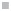
Effects of levosimendan on intracellular cAMP and cGMP in human PAs and PVs.A): cAMP:
■ PA: control (n = 5); ■ PA: 1 μM levosimendan (n = 4); ■ PA: 100 μM levosimendan (n = 7); ■ PV: control (n = 6); ■ PV: 1 μM levosimendan (n = 4); ■ PV: 100 μM levosimendan (n = 8). B): cGMP:
■ PA: control (n = 5); ■ PA: 1 μM levosimendan (n = 3); ■ PA: 100 μM levosimendan (n = 6); ■ PV: control (n = 3); ■ PV: 1 μM levosimendan (n = 3); ■ PV: 100 μM levosimendan (n = 6). A/B: Statistics was performed by the Mann-Whitney U test. P<0.05 are considered as significant: * p<0.05 or ** p<0.01.